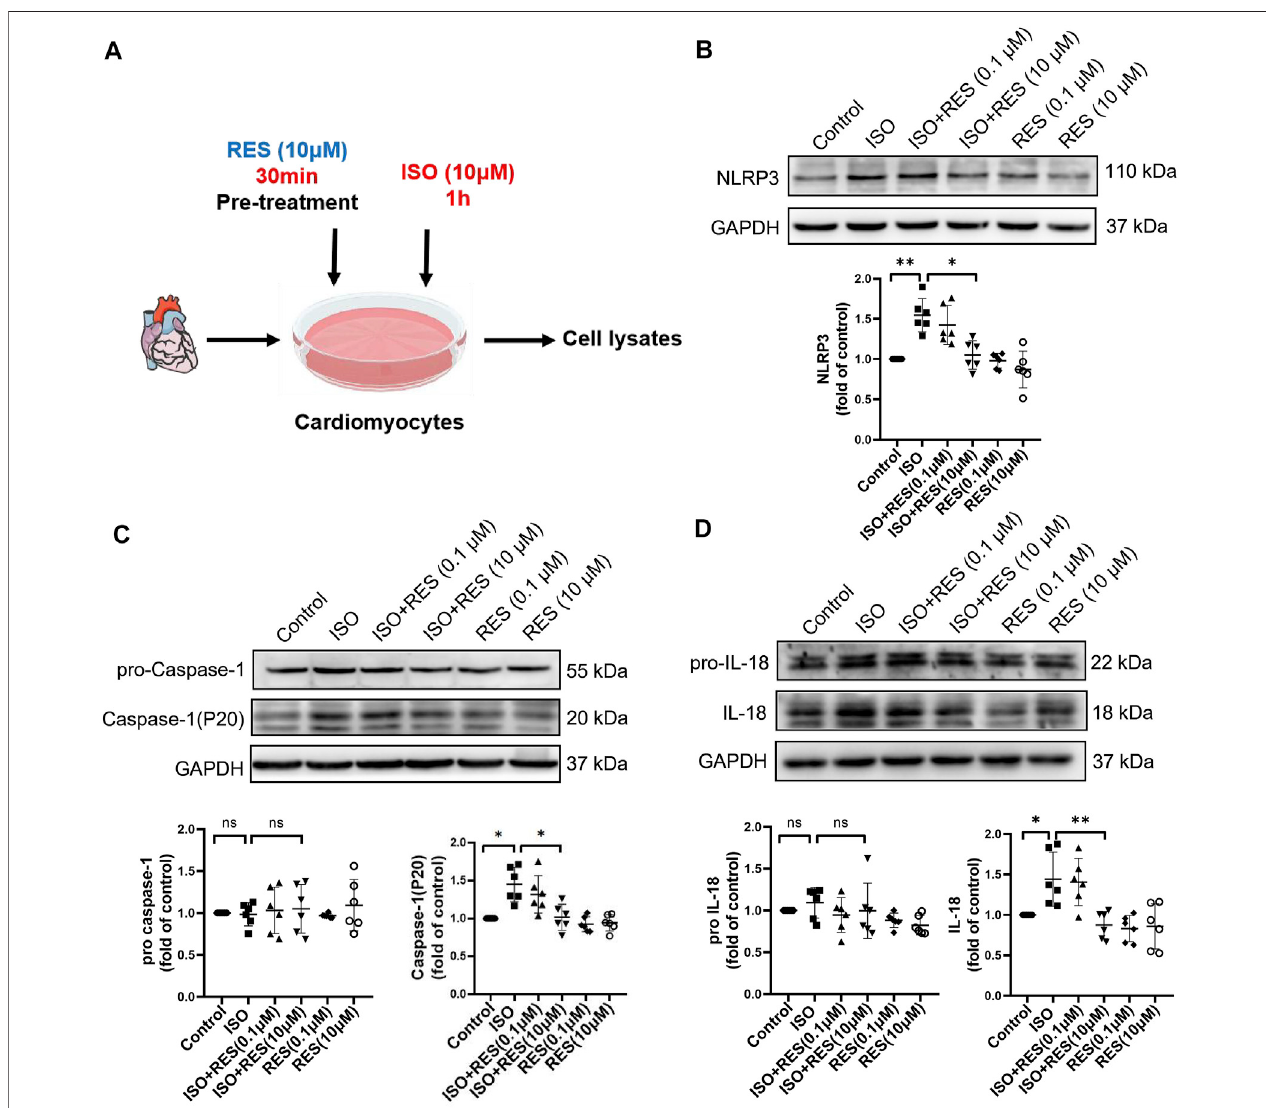
FIGURE 5 | Resveratrol inhibits isoproterenol-induced NLRP3 in fl ammasome activation in NMCM. NMCMs were exposed to isoproterenol (10 μ mol L − 1 ) for 1 h withorwithoutresveratrol(100 nmol/l)or(10 μ mol/l)pretreatmentfor30 min. (A) ModeinNMCMs. (B – D) TheproteinlevelsofNLRP3,pro-caspase-1,caspase-1(P20), pro-IL-18, and cleaved IL-18 were detected by western blotting. n = 6; * p < 0.05; ** p < 0.01; *** p < 0.001; RES, Resveratrol; ISO, isoproterenol. Data are mean ± SD (Kruskal-Wallis ANOVA with post-hoc Dunn ’ s multiple comparison tests).